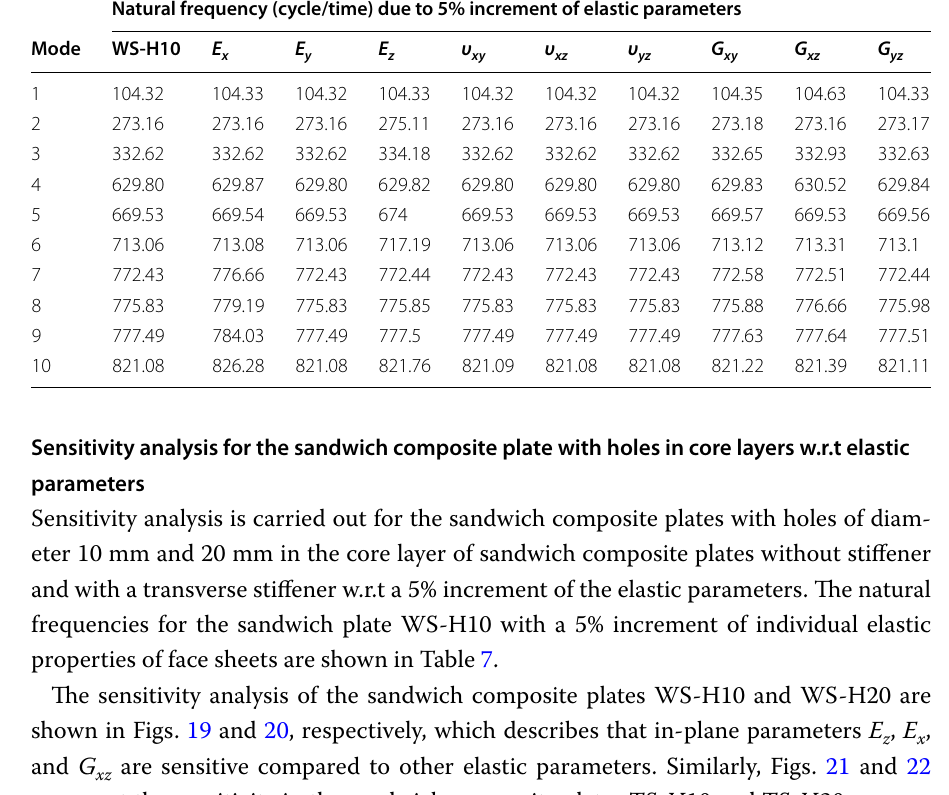
Table 7 Natural frequencies for the WS-H10 after increasing 5% of face layer elastic parameters Natural frequency (cycle/time) due to 5% increment of elastic parameters Mode WS-H10